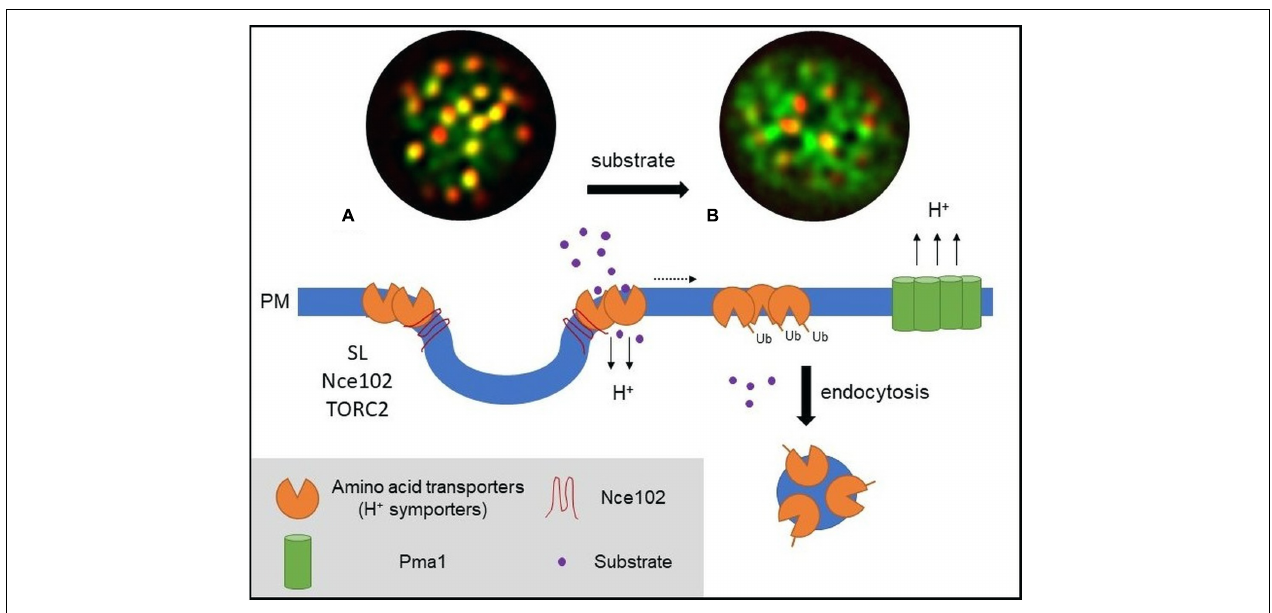
FIGURE 1 | Model of PM amino acid transporter regulation in yeast. (A) Amino acid transporters, generally proton symporters, accumulate at the membrane compartment occupied by Can1 (MCC) during substrate starvation. The MCC represents the edge area of PM furrows (also termed eisosome). Clustering of permeases depends on sphingolipids (SL), the tetraspan protein Nce102, and TORC2 signaling. Clustered transporters adopt an open (outward facing) conformation. (B) Substrate transport triggers a conformational switch to a closed (inward facing) conformation. This switch is linked to lateral relocation of the transporters out of the MCC (dotted arrow) into a unique PM area that is distinct from that occupied by the H + -ATPase Pma1 (MCP). The conformational switch and lateral relocation precede transporter ubiquitination. Ubiquitinated transporters then act as a molecular beacon for the recruitment of the endocytic machinery. Fluorescent images (TIRF) have been adapted from Busto et al. (2018) and represent composites of a ubiquitination-deficient mutant of the methionine permease Mup1 (Mup1-2KR, green) and the eisosomal core component Pil1 (red). Mup1-2KR clusters within the MCC in the absence of methionine (left, colocalization with Pil1 in yellow patches) and relocates out of MCC clusters upon substrate